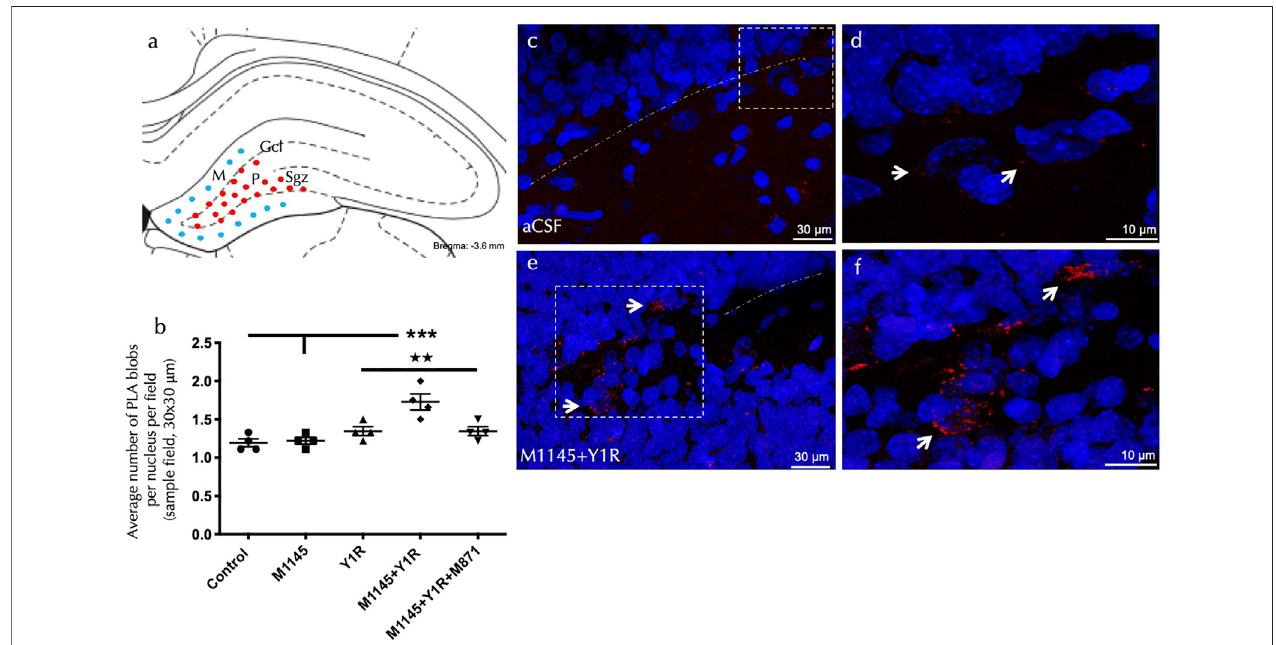
FIGURE 3 | GALR2/Y1R heteroreceptor complexes are detected by in situ PLA in the dorsal dentate gyrus (DG). (A) The diagram shows the presence of positive red PLA signals (red circles) mainly in the subgranular zone (Sgz) of the dentate gyrus at the border between the granular cell layer (Gcl) and polymorphic layer (P) of the dentate gyrus in the dorsal hippocampus. PLA positive red signals were also observed in the polymorphic layer. Blue- fi lled circles indicate a negative PLA signal in the molecular layer (M). [Bregma: – 3.6 mm; according to the Paxinos and Watson (1998) stereotaxic atlas]. (B) Quanti fi cation of PLA signals in Sgz was performed by measuring red PLA positive blobs per nucleus per sampled fi eld by an experimenter blind to treatment conditions. Sprague Dawley rats signi fi cantly increased GALR2- Y1R heterocomplexes (PLA blobs) in the Sgz after M1145 and Y1R agonist intranasal administration. This effect was blocked by treatment with the GALR2 antagonist M871. *** p < 0.001 vs. control and M1145; ++ p < 0.01 vs. Y1R and M1145 + Y1R + M871 according to one-way ANOVA (F4, 15 = 10.21, p < 0.001) followed by Newman-Keuls post-hoc test. Inter-group comparisons are indicated by the vertical lines from the horizontal line above bars. Data are expressed as mean ± SEM, four ratspergroup,duplicates). (C – F) Representativemicrophotographsofthesigni fi cantincreaseinthedensityofGALR2-Y1RpositiveredPLAblobsintheSgzsub-region after GAL and Y1R agonist coinjection (E) compared with the control group (C) . Magni fi ed views from dashed boxes in (C,E) are shown in (D,F) , respectively. GALR2- Y1R heteroreceptor complexes are shown as red PLA blobs (clusters)found in high densities per cell in many nerve cells using confocal laser microscopy. White arrows point to PLA positive clusters. Dashed lines outline the Gcl of the dentate gyrus. The nuclei are shown in blue by DAPI. Abbreviations: Control = Distilled water; M1145 = Galanin2receptoragonist132 µg;Y1R=Y1Rreceptoragonist[Leu 31 -Pro 34 ]NPY132 µg;M1145+Y1R=CoadministrationofM1145andY1R;M1145+Y1R+M871 = Coadministration of M1145, Y1R and GALR2 antagonist M871 132 µg. Treatments were performed 24 h before brain processing; see material and methods for further